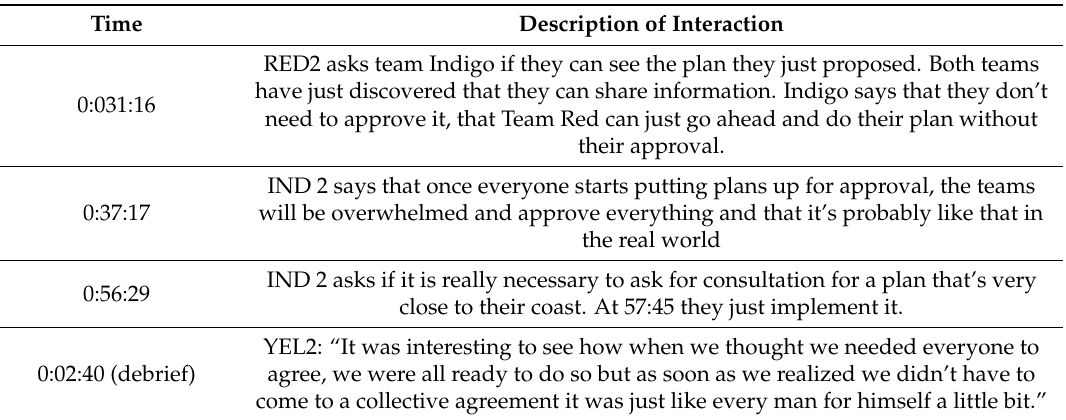
Table 7. Interactions regarding consultation for project